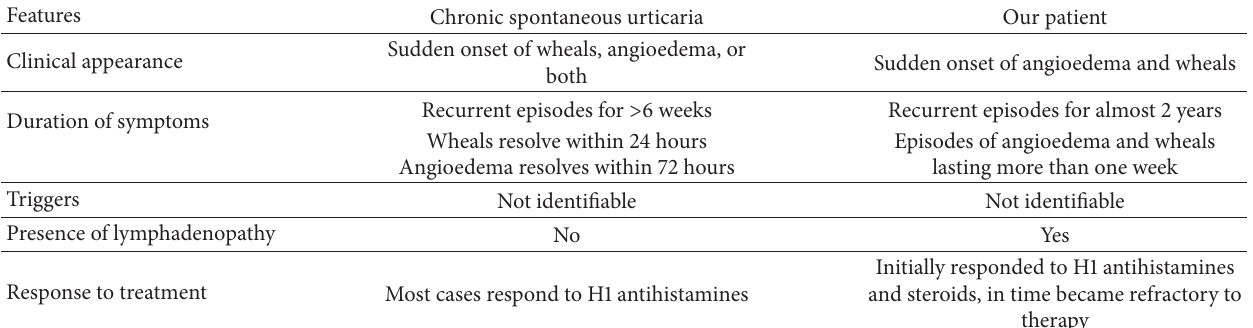
Table 1: Typical features of chronic spontaneous urticaria versus features in our